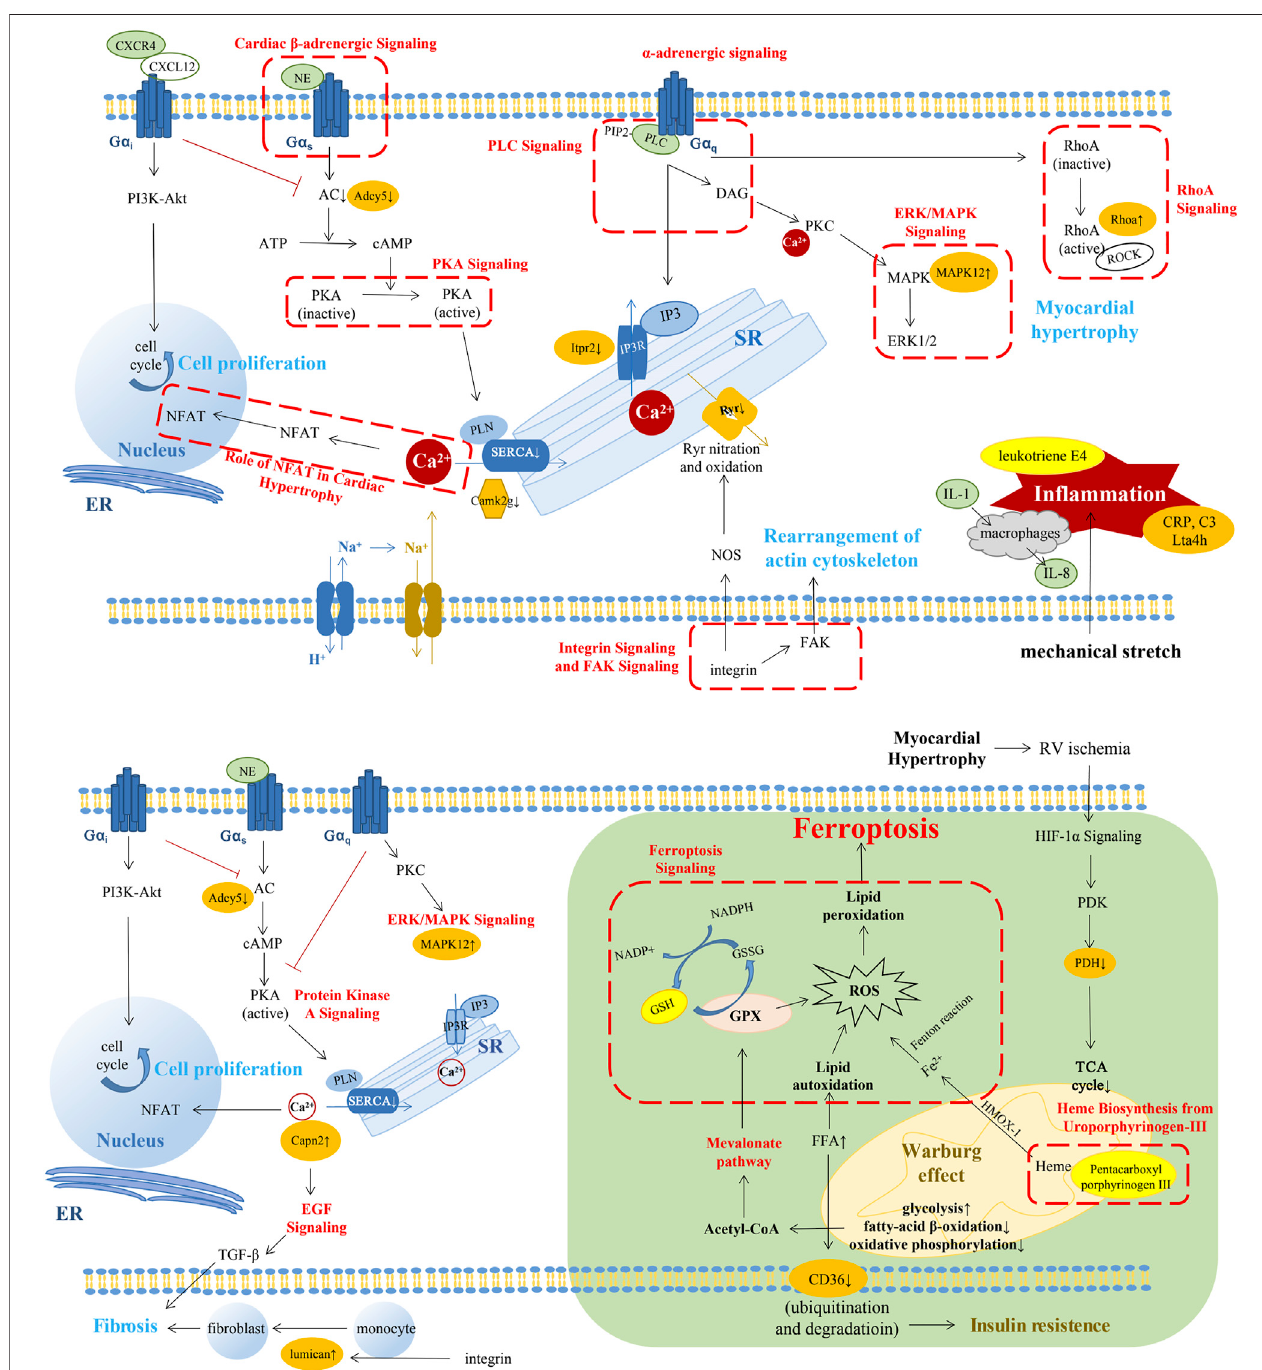
FIGURE6| AsummarypatterndescribingthekeychangesinthemolecularandpathwaylevelthroughRVFprogression.Thechangesinthecompensatedstageof RV(above).ThechangesinthedecompensatedstageofRV(below).Thechangesingreenbackgroundrepresentedournovel fi ndings.Thepathwaysinredfontorinred dashed box were the altered pathways which were the same with previous studies. Molecules with orange highlights represented the importantly altered proteins in our results. Molecules with bright yellow highlights represented the importantly altered metabolites in our results. SERCA2, sarcoplasmicreticulum(SR) Ca 2+ -ATPase; PIP2, phosphatidylinositol-4,5,-bisphosphate; IP3, inositol-1,4,5-trisphosphate; Itpr2, inositol 1,4,5-trisphosphate receptor type 2; Camk2g, calcium/calmodulin- dependent protein kinase type II subunit gamma; ADCY5, adenylate cyclase type 5; MAPK, mitogen-activated protein kinase; DAG, diacylglycerol; NOS, nitric oxide synthase; NFAT, nuclear factor of activated T cells; ROCK, the RhoA-Rho kinase; Lta4h, leukotriene A-4 hydrolase; GPX4, glutathione peroxidase 4; HIF-1 α , hypoxia- inducible factor 1 α ; PDK, pyruvate dehydrogenase kinase; PDH, pyruvate dehydrogenase; and FFA, free fatty acid.